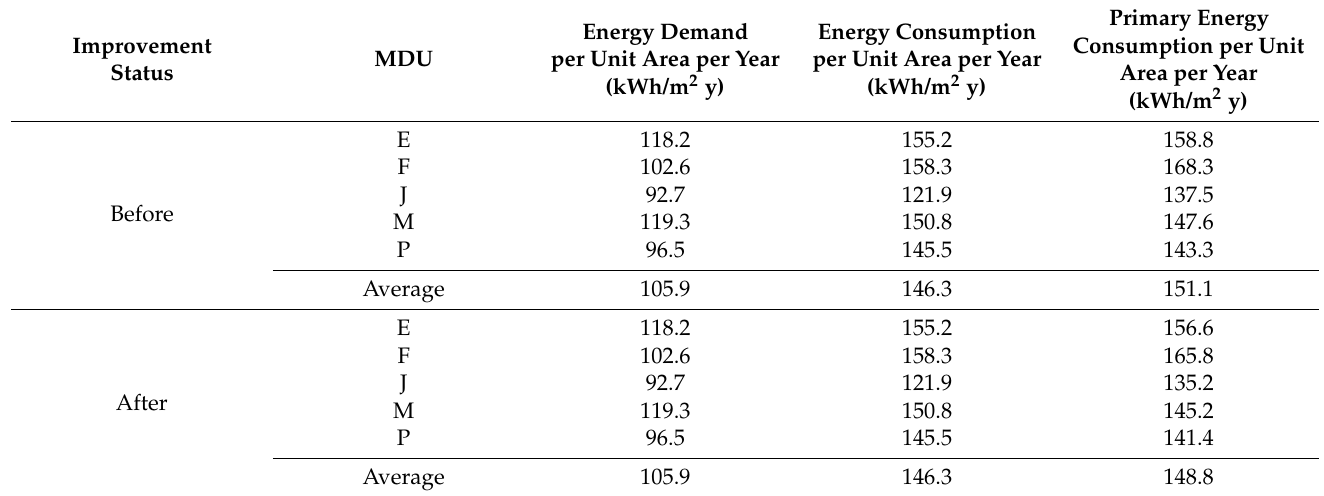
Figure 10. Input and simulation results of ECO2 before and after application of solar PV renewable system in MDU F. Table 7. Changes in energy demand and energy consumption of E, F, J, M, and P MDU complexes before and after solar PV system